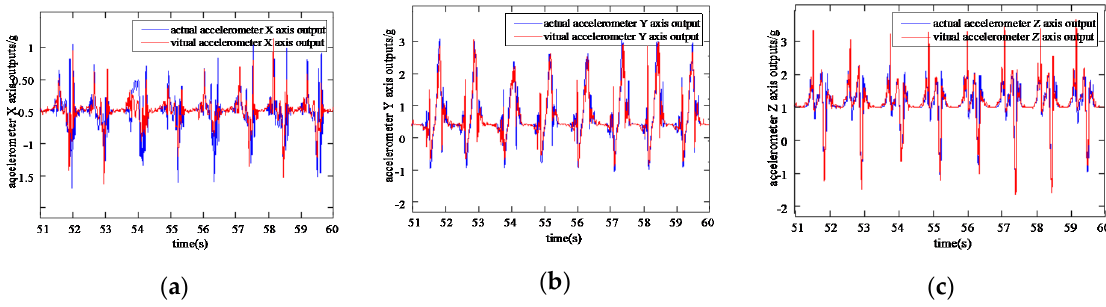
Figure 7. Information comparison of virtual accelerometers with reference accelerometers ( a ) Comparison of virtual accelerometer X axis information with reference accelerometer X axis information; ( b ) Comparison of virtual accelerometer Y axis information with reference accelerometer Y axis information; ( c ) Comparison of virtual accelerometer Z axis information with reference accelerometer Z axis information.